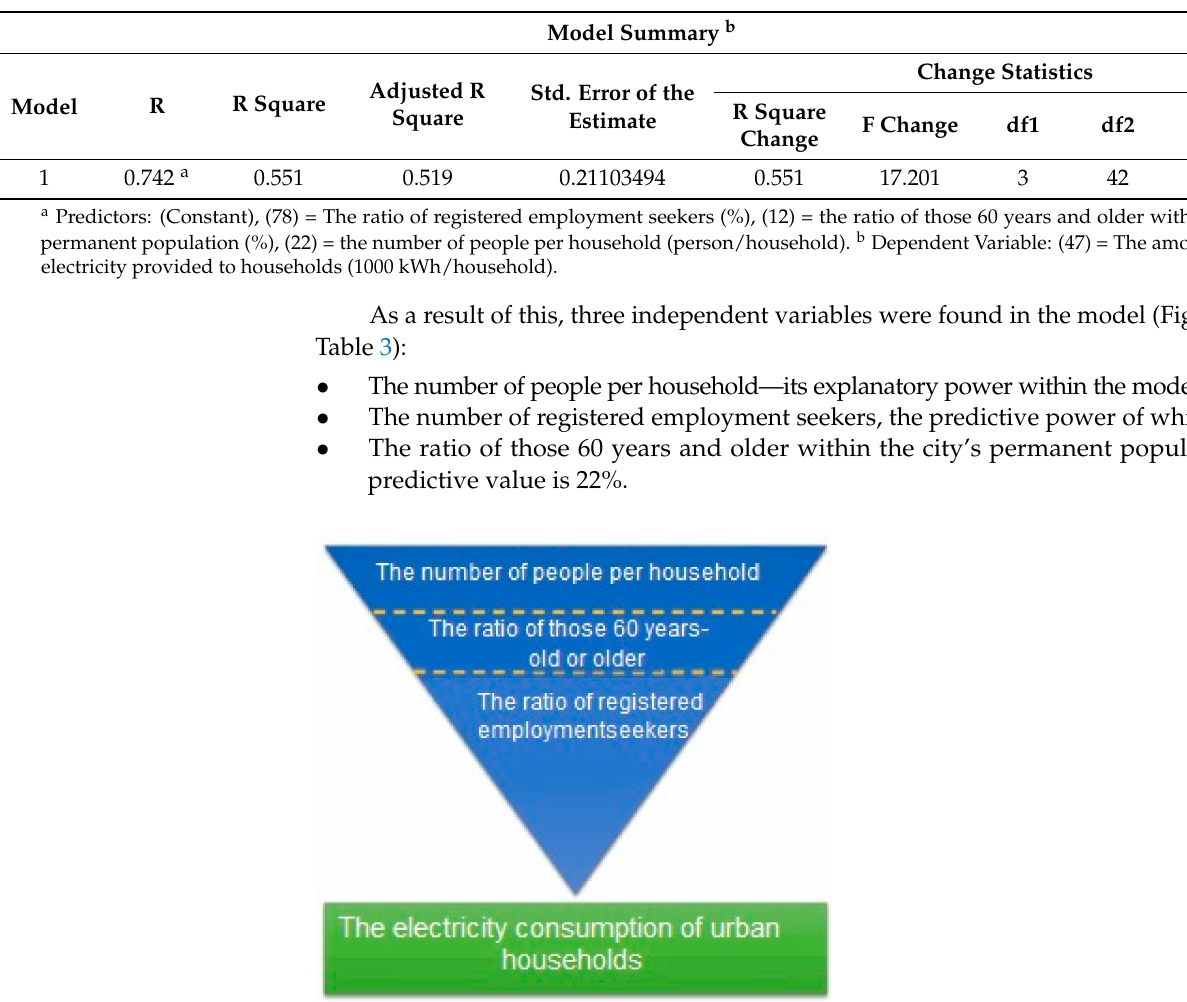
Table 2. The result of the variance.